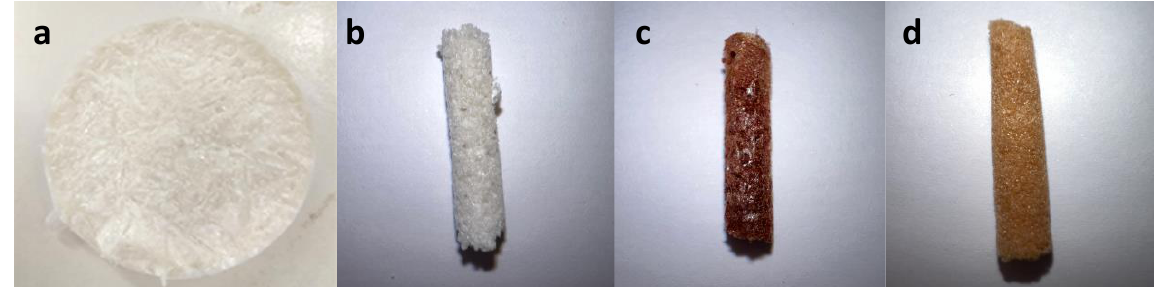
Figure 2. Macroscopic appearance of ( a ) sample SF, ( b ) sample A2, ( c ) sample B3 and ( d ) sample C4.